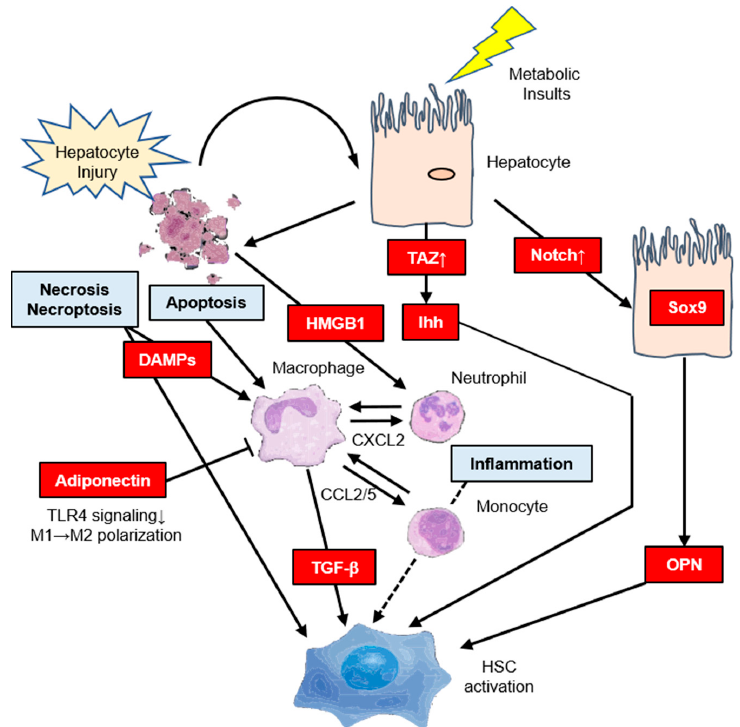
Figure 2. The indirect pathways regulating hepatic stellate cell (HSC) activation in steatohepatitis. Metabolic insults such as hyperinsulinemia/hyperglycemia lead to the activation of transcriptional coactivator with PDZ-binding motif (TAZ) in hepatocytes. Increased hepatocyte expression of TAZ